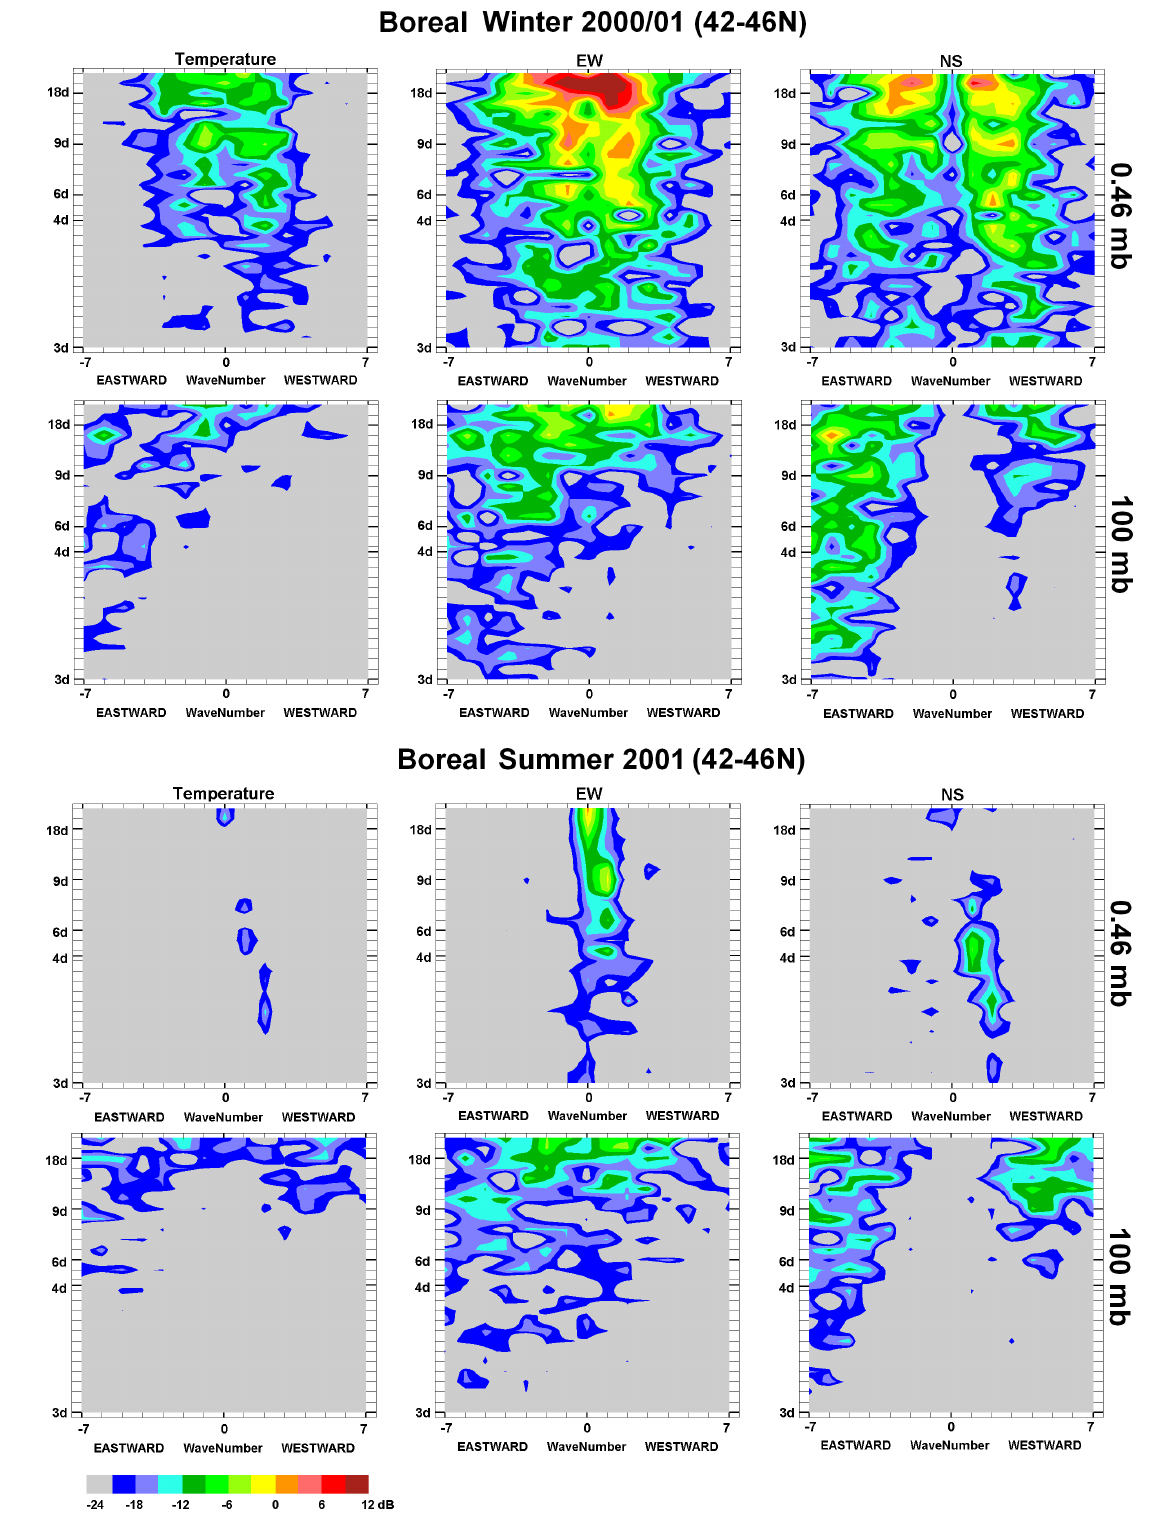
Fig. 8. Wave numbers versus frequency calculated for MetO temperatures (left), zonal, EW, (middle) and meridional, NS, (right) wind components at the 0.46 and 100mbar pressure levels for 42–46N latitude band during the 2000/01 winter (December 2000 − February 2001) (two upper rows) and the 2001 summer (two bottom rows). Some periods are shown for convenience, the divisions are cycles per 90 days and range from 3 (top) to 30